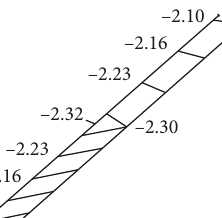
Figure 15: Shear stress in the concrete face under condition 1 with the water level at 3283m (units: MPa).